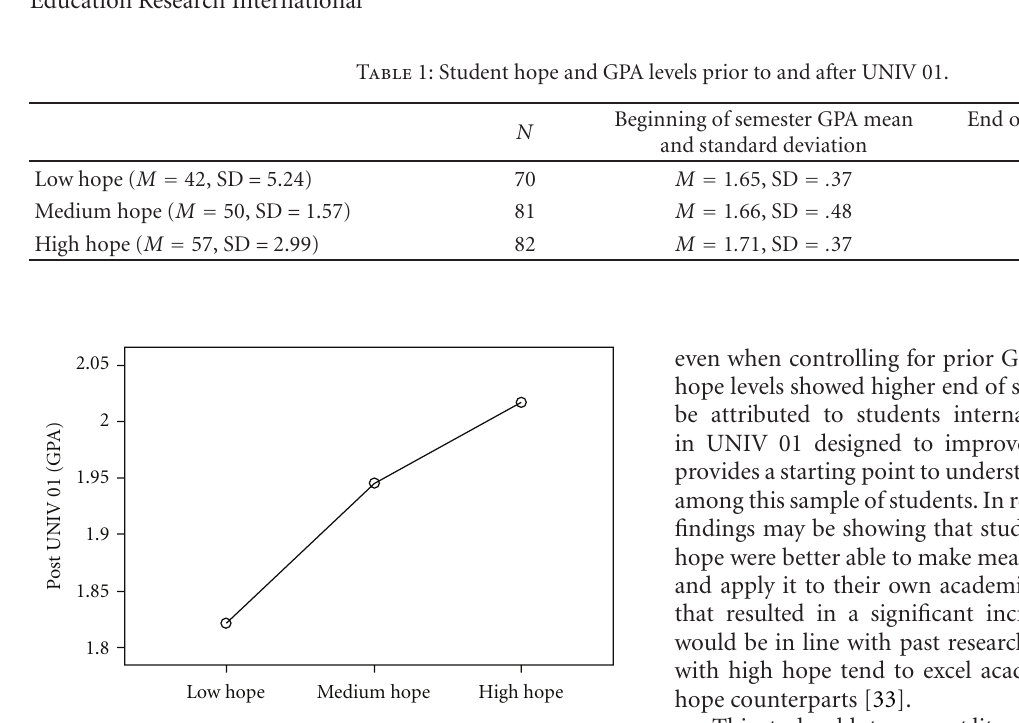
Figure 1: Student post UNIV 01 GPA by hope